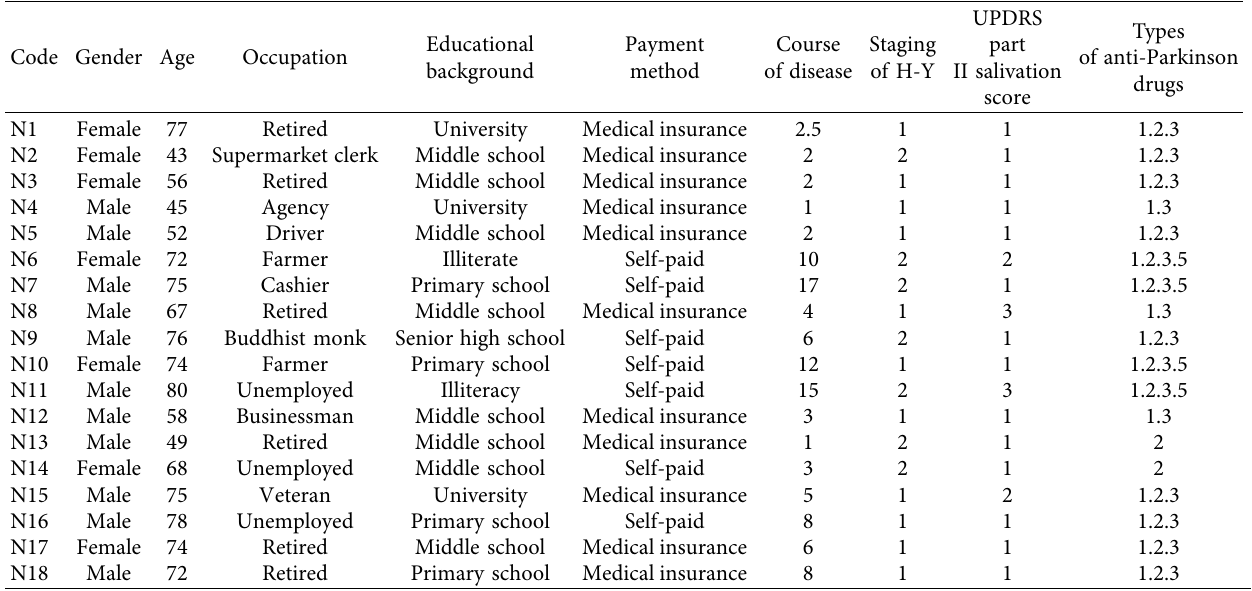
Table 1: Basic information of the